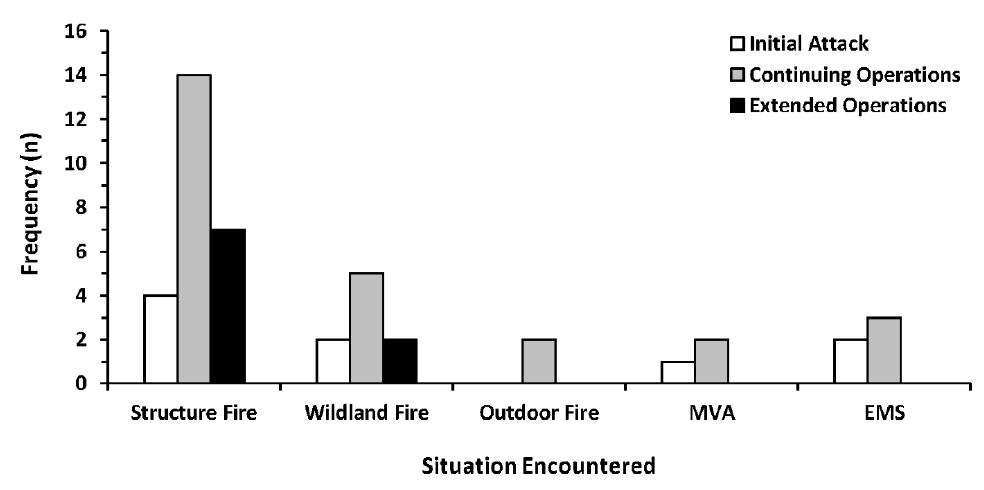
Figure 1. Frequency of fatal cardiac events by emergency situation encountered and incident